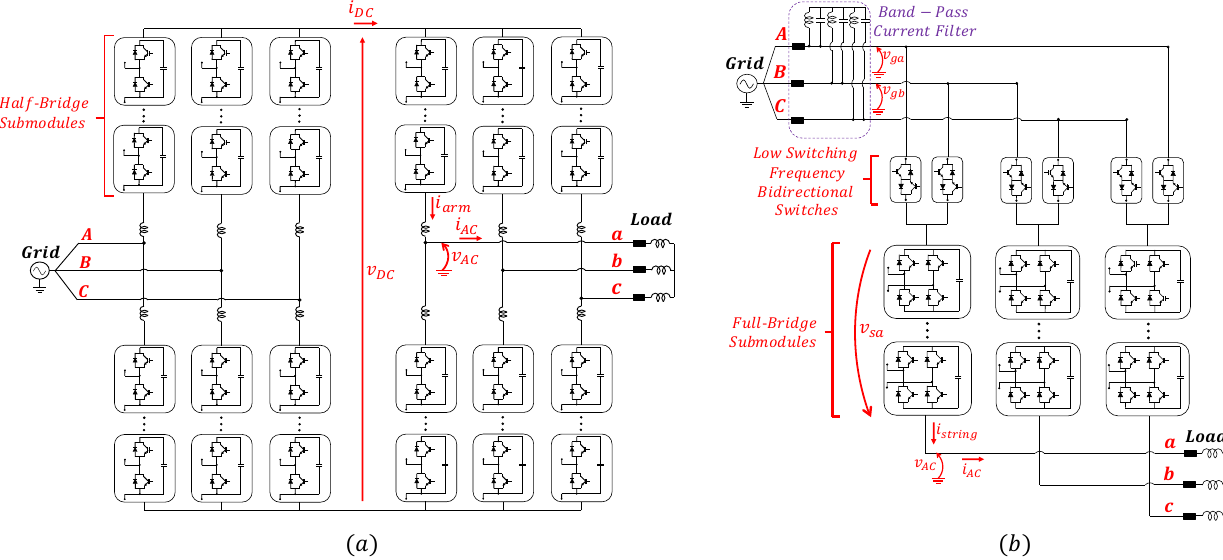
Figure 1. ( a ) Modular multilevel converter (MMC) topology in the back-to-back configuration and ( b ) modular multilevel series converter (MMSC)